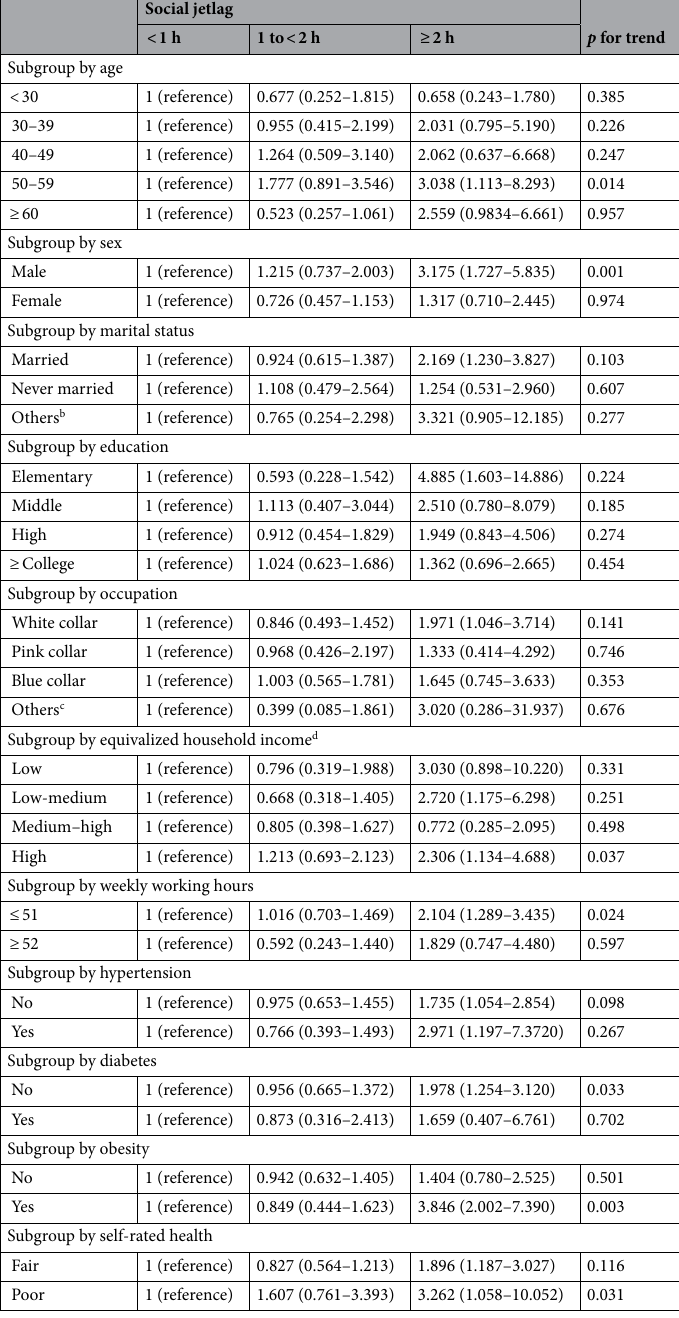
Table 3. The risk of chronic kidney disease according to the categories of social jetlag by subgroup a . a Adjusted odds ratio was calculated by multiple logistic regression analysis after adjusting for age, sex, marital status, occupation, weekly working hours, smoking, drinking, hypertension, diabetes, obesity, and self-rated health. b Widowed, separated, or divorced. c Workers in the agriculture, forestry, fishery, and military sectors. d Gross household income was divided by the square root of household